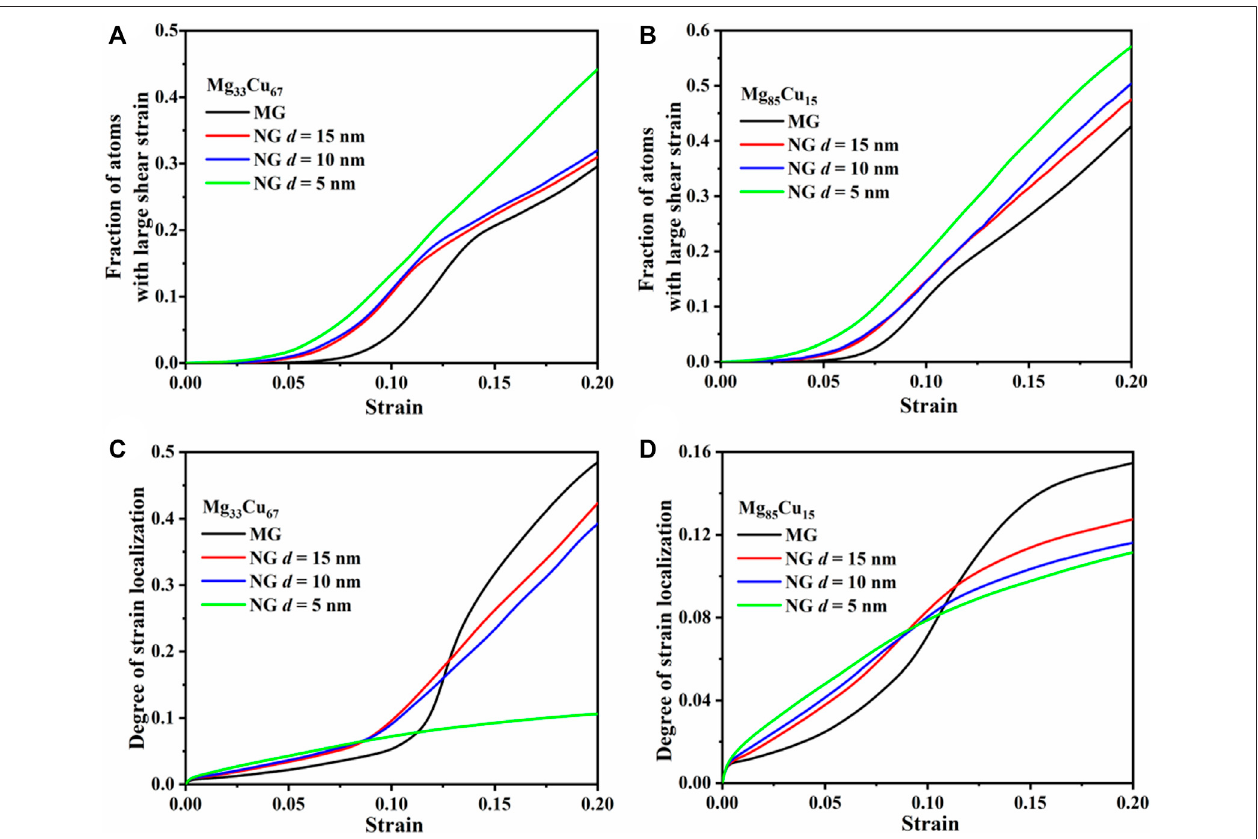
FIGURE 4 | (A,B) The fraction of atoms with large η Mises ≥ 0 . 2, and (C,D ) the strain localization parameter values during deformation for Mg 33 Cu 67 and Mg 85 Cu 15 NGs with d = 15, 10, and 5 nm. The trends in the MG counterparts are also plotted for